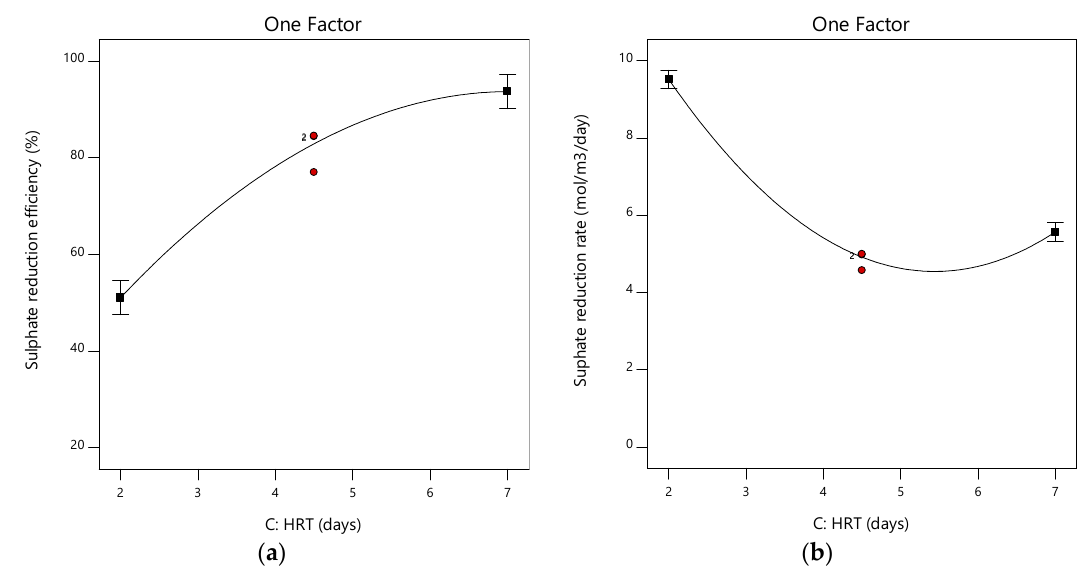
Figure 8. HRT effect on ( a ) sulphate reduction efficiency and ( b ) sulphate reduction rate at 20 °C and Figure 8. HRT e ff ect on ( a ) sulphate reduction e ffi ciency and ( b ) sulphate reduction rate at 20 ◦ C and pH 5. pH 5.